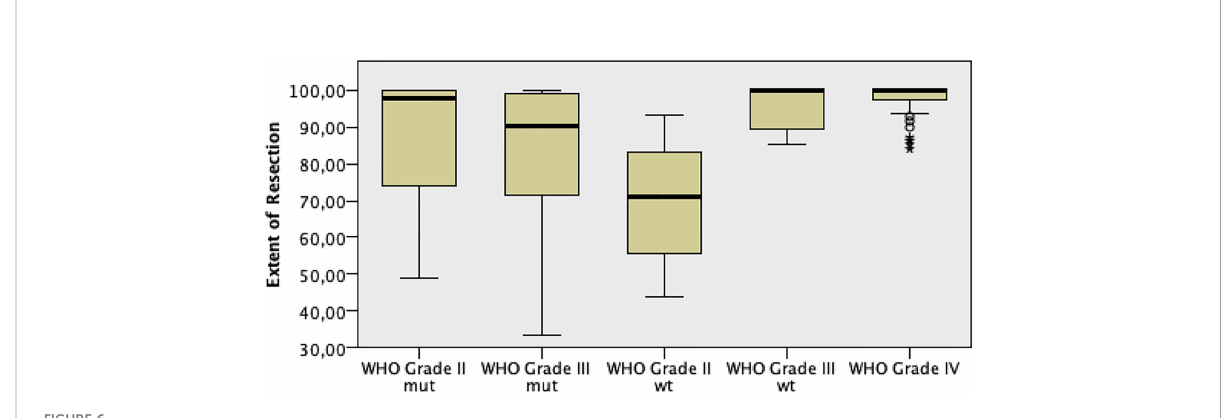
FIGURE 6 EOR comparison among the different WHO 2016 grade